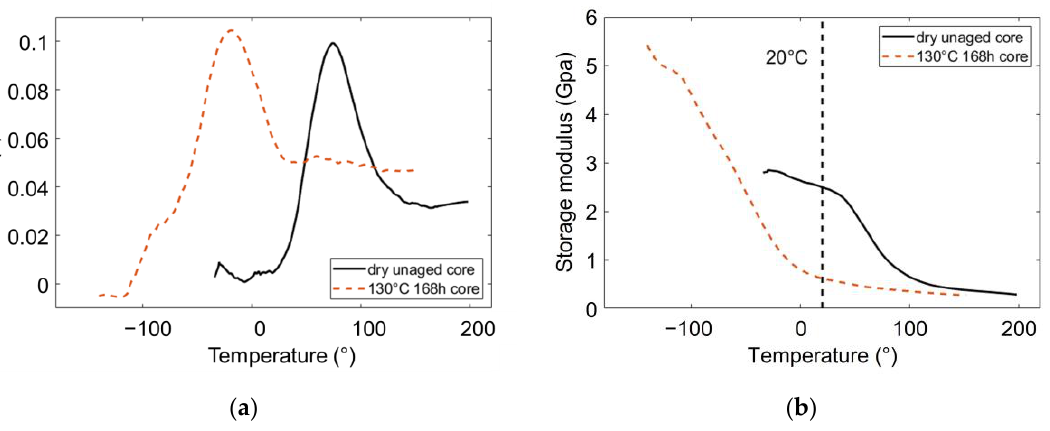
Figure 13. ( a ) Decrease of the damping factor peak to lower temperature after aging; ( b )Typical storage modulus curves before and after aging. Table 2. T α for the dry unaged and the aged